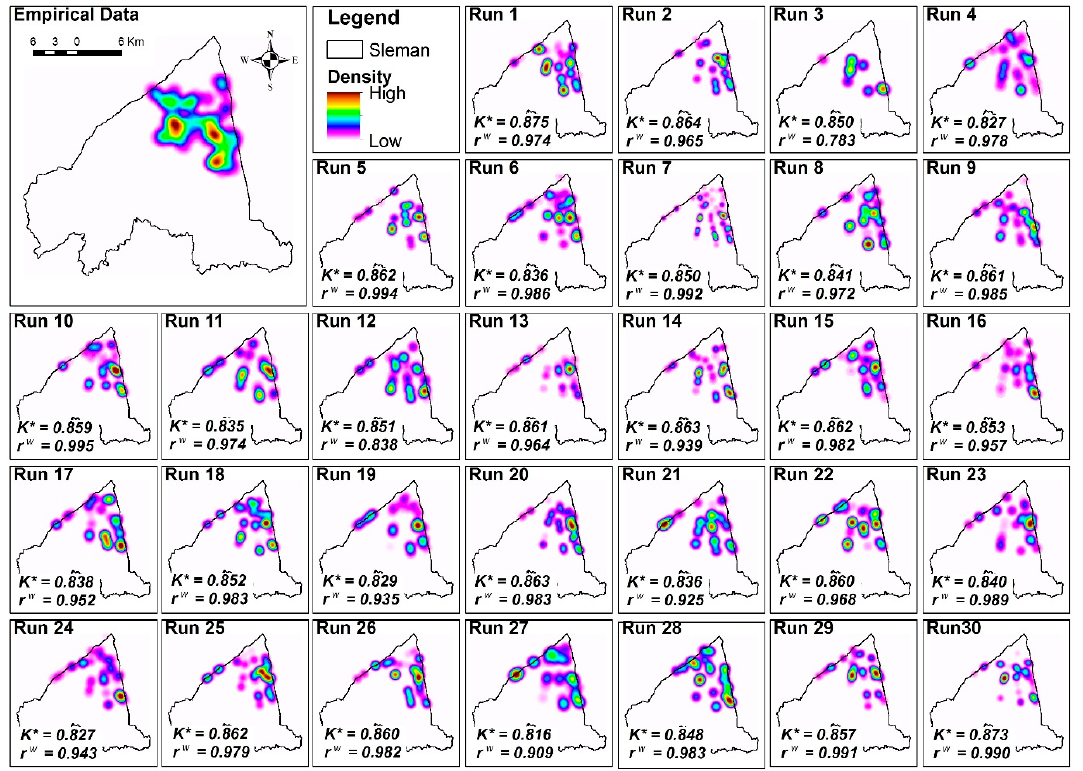
Figure 8. Spatial comparison of simulated and observed reluctance distribution based on scenario